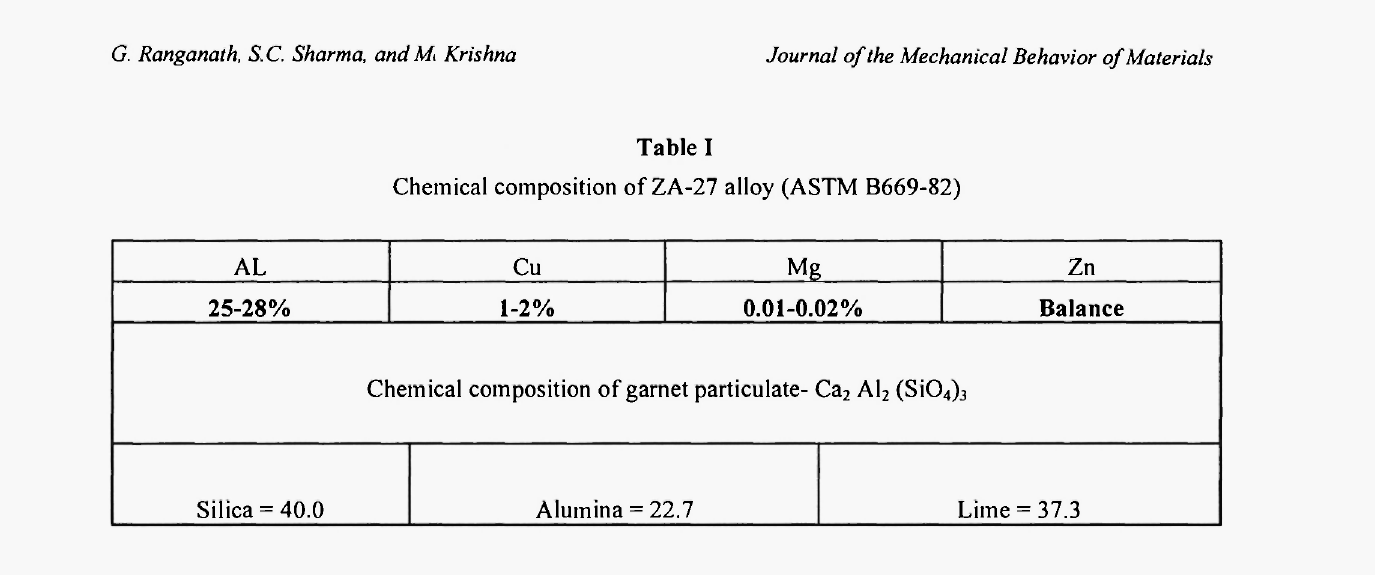
Chemical composition of ZA-27 alloy (ASTM